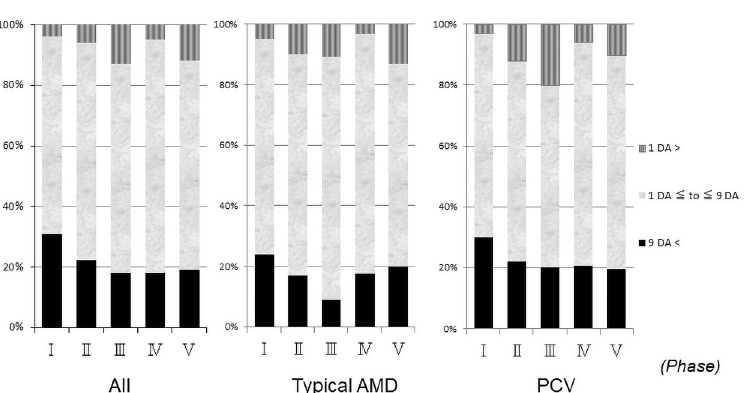
Fig 5. Changes of the distribution in the lesion sizes for 1,777 eyes. The prevalence rates of large lesions in phases II, III, IV, and V are significantly ( P = 0.022, P < 0.001, P < 0.001, P < 0.001, respectively, chi-square test) smaller compared with phase I. Phases I, II, III, IV, and V spanned, respectively, March 2003 to February 2005, March 2005 to February 2007, March 2007 to February 2009, March 2009 to February 2011 and March 2011 to February 2013. DA = disc area; PCV = polypoidal choroidal vasculopathy; AMD = age-related macular degeneration.